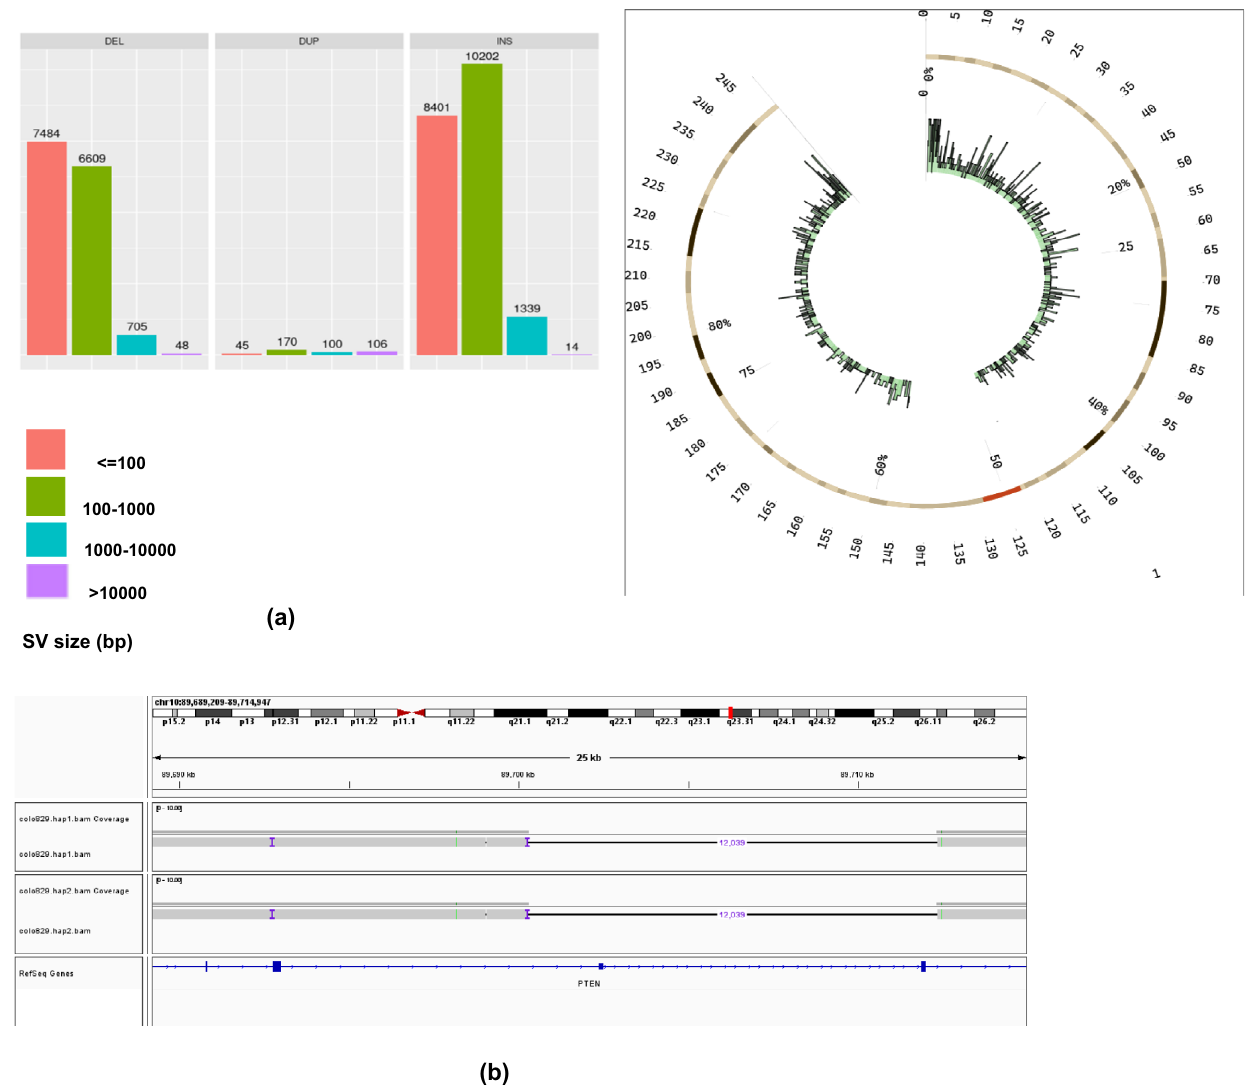
Fig. 5 | a Whole-genome precise SV characterisation of COLO829 (Top). SV types and size distributions and the circos plot shows SV distribution for chromosome 1. b Identi fi cation of a homozygous 12 kbp deletion affecting PTEN on chromosome 10 (Bottom). Source data are provided as a Source Data fi